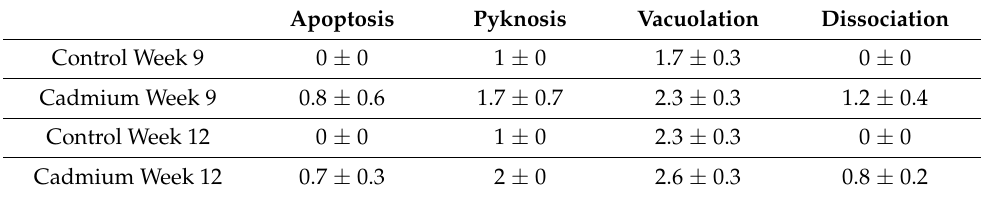
Table 1. Hematoxylin and eosin (H&E) stained pancreatic islets from cadmium- and saline-treated animals were evaluated by a trained veterinary pathologist for: apoptosis, pyknosis, vacuolation and dissociation.